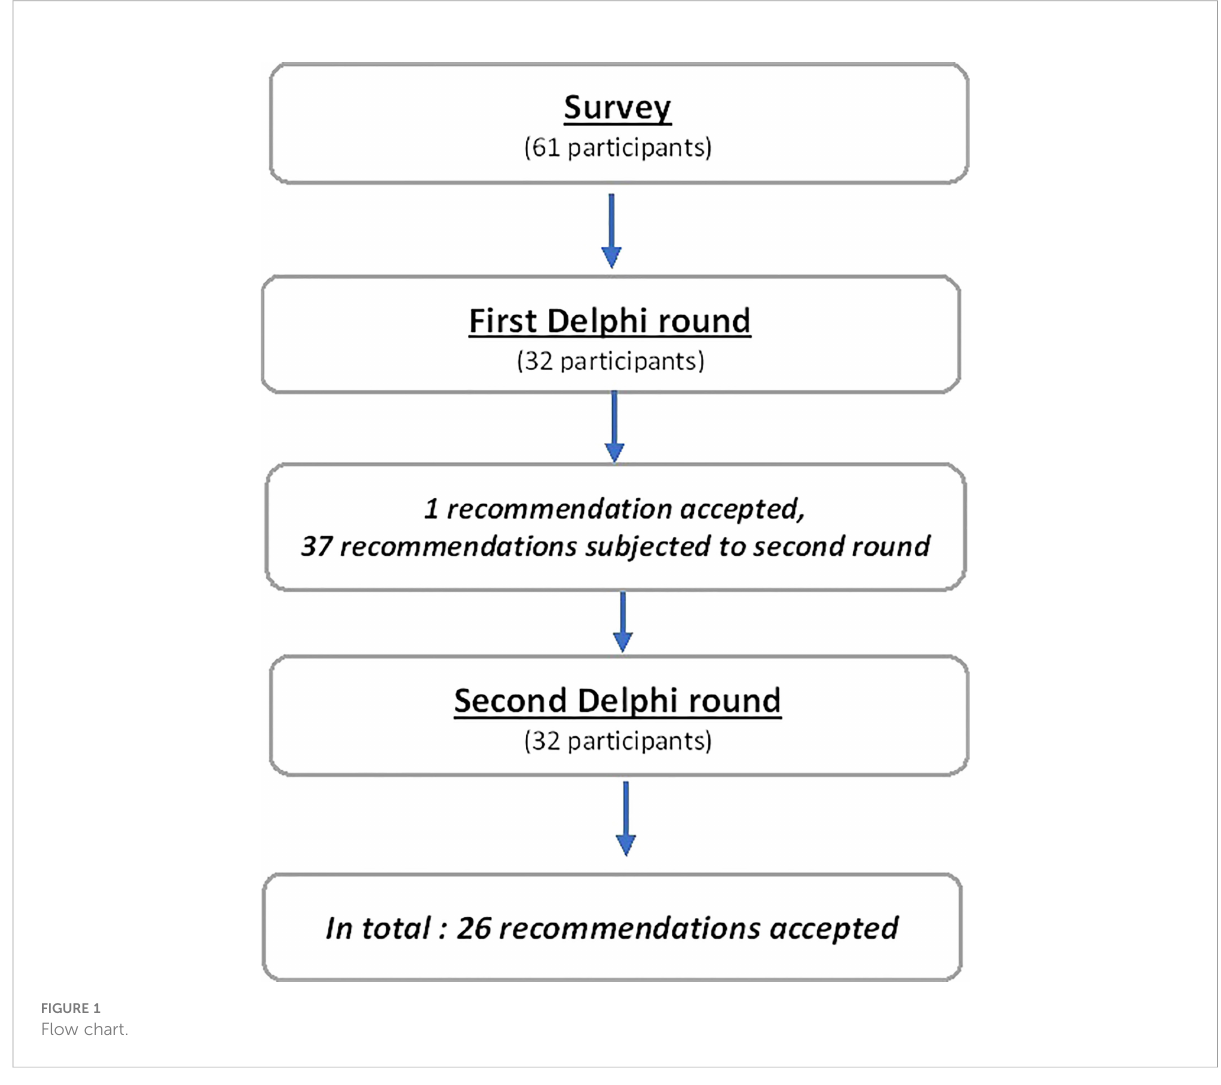
FIGURE 1 Flow chart.